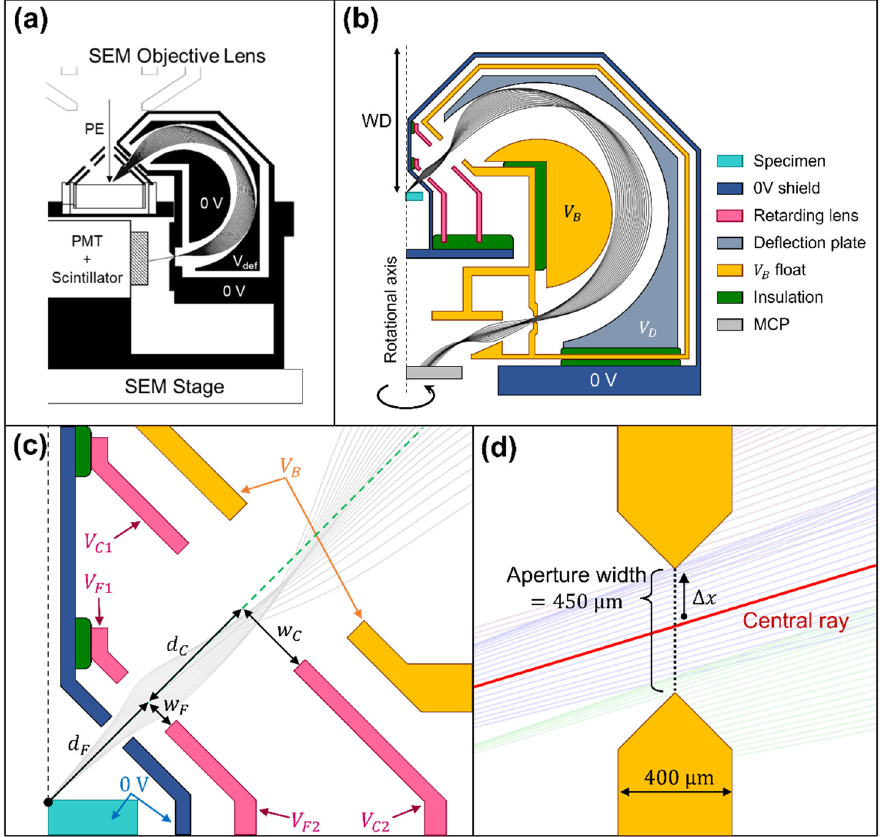
Figure 1. Schematic drawing of SEM toroidal energy spectrometer attachment designs. ( a ) A previous design for secondary electron energy spectroscopy (SEES). ( b ) Present design for reflection electron energy spectroscopy (REELS). ( c ) Retarding column lens section in the REELS analyzer design. The four electrodes located between the outer 0 V casing plate and the analyzer entrance plate held at voltage V B control the way the incoming electrons are slowed down before they enter the